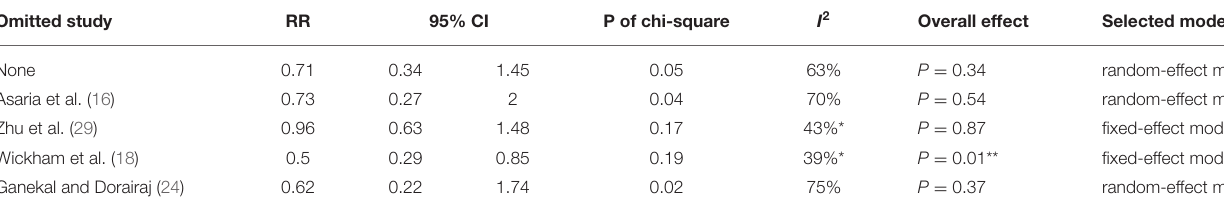
TABLE 6 | Sensitivity analysis for additional outcome: number of vitreoretinal reoperations due to postoperative PVR. Omitted